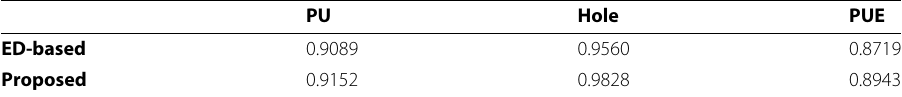
Table 4 AUROC values for PUEA PU Hole PUE ED-based 0.9089 0.9560 0.8719 Proposed 0.9152 0.9828 0.8943